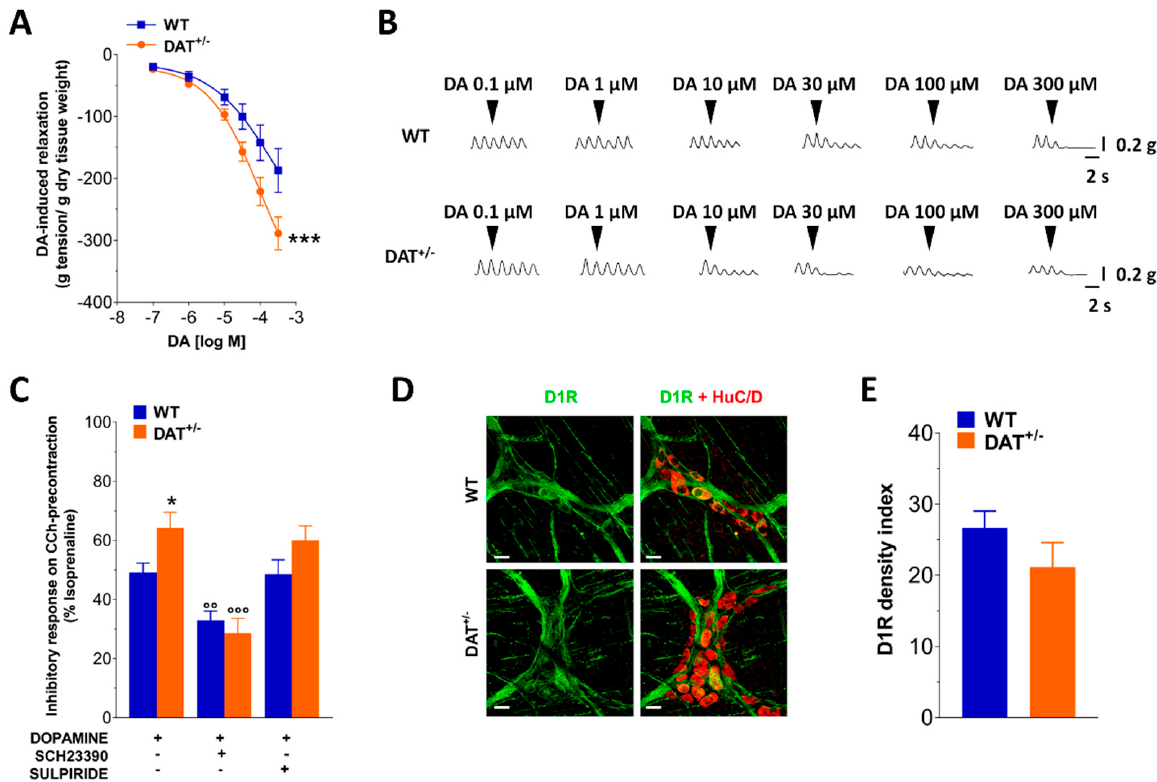
Figure 1. DAT hypofunction affects dopaminergic neuromuscular response. ( A ) Inhibitory concentration–response curves to dopamine (DA) on spontaneous contractile activity of isolated ileal preparations from WT and DAT +/ − mice. ( B ) Repre- sentative tracings of responses induced by increasing dopamine (DA) concentration of in WT and DAT +/ − preparations. ( C ) 30 µ M dopamine-induced relaxation of CCh-precontracted ileal preparations with or without SCH23390 or sulpiride in isolated ileal segments of WT and DAT +/ − mice. ( D ) Representative confocal microphotographs showing the distribution of D1R (green, marker for D1 receptor) and HuC/D (red, pan-neuronal marker) and ( E ) D1R density index in LMMP preparations of WT and DAT +/ − mice. Scale bars = 22 µ m. Data are reported as mean ± SEM. * p < 0.05, *** p < 0.001 vs. WT mice; ◦◦ p < 0.01, ◦◦◦ p < 0.001 vs. respective control in absence of antagonist. n = 5